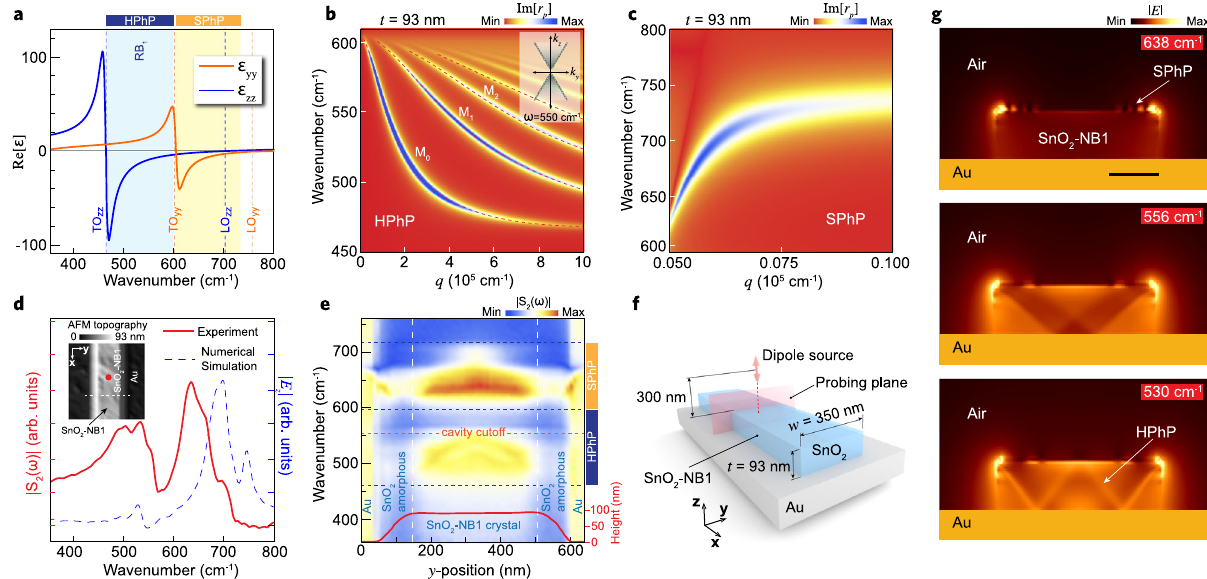
Fig. 2 Polaritonic activity in SnO 2 -NBs. a Real part components of the electrical permittivity ( ε yy and ε zz ) of SnO 2 showing the hyperbolic (HPhP) spectral region (light blue-shaded Reststrahlen band type I, RB 1 ) and surface phonon polaritons (SPhP) window (light yellow-shaded). b , c Dispersion relation for volume (HPhPs) and surface (SPhPs) phonon polaritons in SnO 2 , respectively. False-color plot represents the calculated imaginary part of the complex re fl ectivity Im ½ r p (cid:3) for an air/SnO 2 /Au multilayered structure. Dashed lines in b represent the Im ½ r p (cid:3) extracted from Eq. 2. M 0 and M 1,2,... represent the fundamental and high order phonon mode dispersions, respectively. Inset b depicts the dispersion in isofrequency at 550 cm − 1 . d SINS amplitude S 2 ( ω ) point spectrum (red solid line) of the SnO 2 -NB1. Inset shows 1 × 1 µ m 2 AFM topography of the SnO 2 -NB1 ( t = 93 nm, w = 350 nm), and the red dot indicates the SINS point spectrum location. FDTD-simulated spectrum (blue dashed line) obtained from | E z | integration along the red-dashed vertical line in f . e SINS spectral linescan along the white-dashed line in the inset d . The red solid line pro fi le at the bottom represents the AFM height of the SnO 2 -NB1. Vertical white-dashed lines delimit amorphous and crystalline SnO 2 phases. Horizontal blue dark-dashed lines denote the HPhPs and SPhPs spectral ranges. The horizontal orange dashed line indicates the cutoff frequency for this NB. f Parameters-space for the FDTD numerical simulations of the SnO 2 - NB1 sample. g Simulated electric fi eld |E| distribution inside the NB revealed by cross-sections at the frequencies 638 (outside RB 1 ), 556, and 530 cm − 1 , respectively. The |E| intensity cross-sections highlight the presence of SPhPs (outside RB 1 ) and volume standing waves (HPhPs inside RB 1